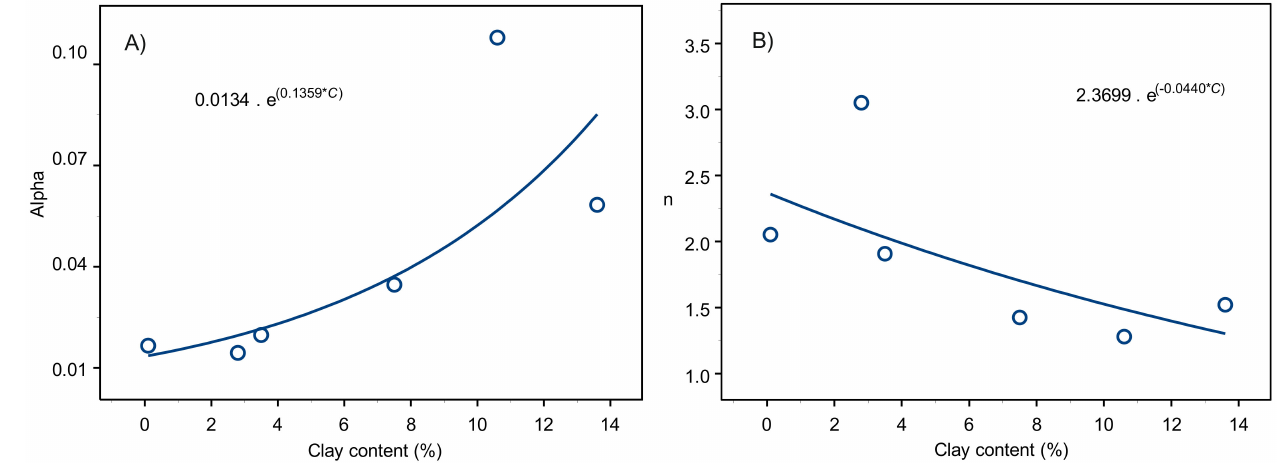
Figure 5. Exponential correlations ( A ) between clay content and α (van Genuchten) and ( B ) between clay content C and n (van Genuchten); data from six reconstructed soil